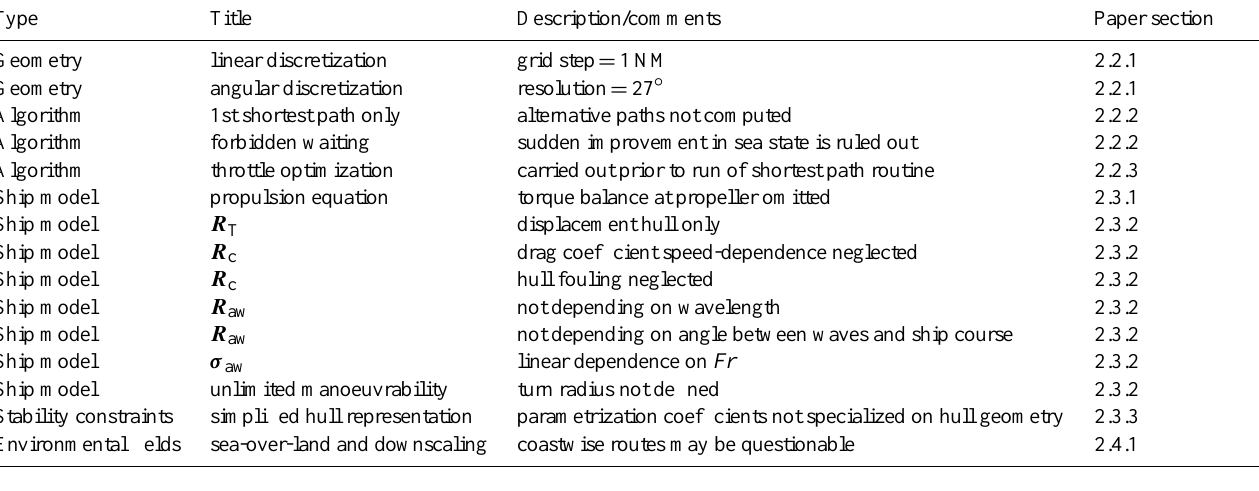
Table 7. List of main approximations done in VISIR-I.